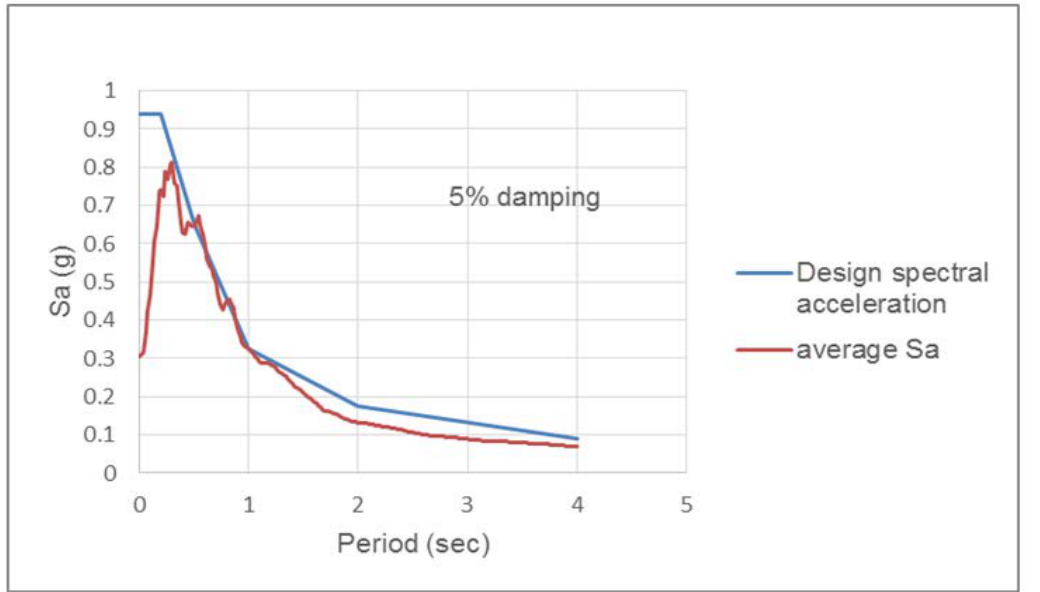
Figure 5. Design spectral acceleration and average acceleration response spectrum.